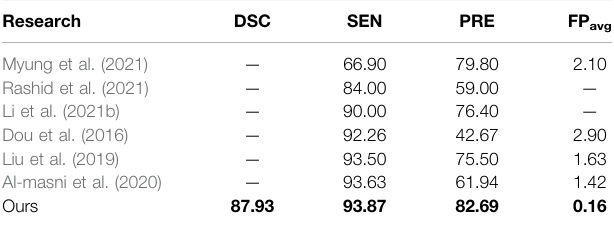
TABLE 5 | Comparison of previous studies on the detection of CMBs and ours.